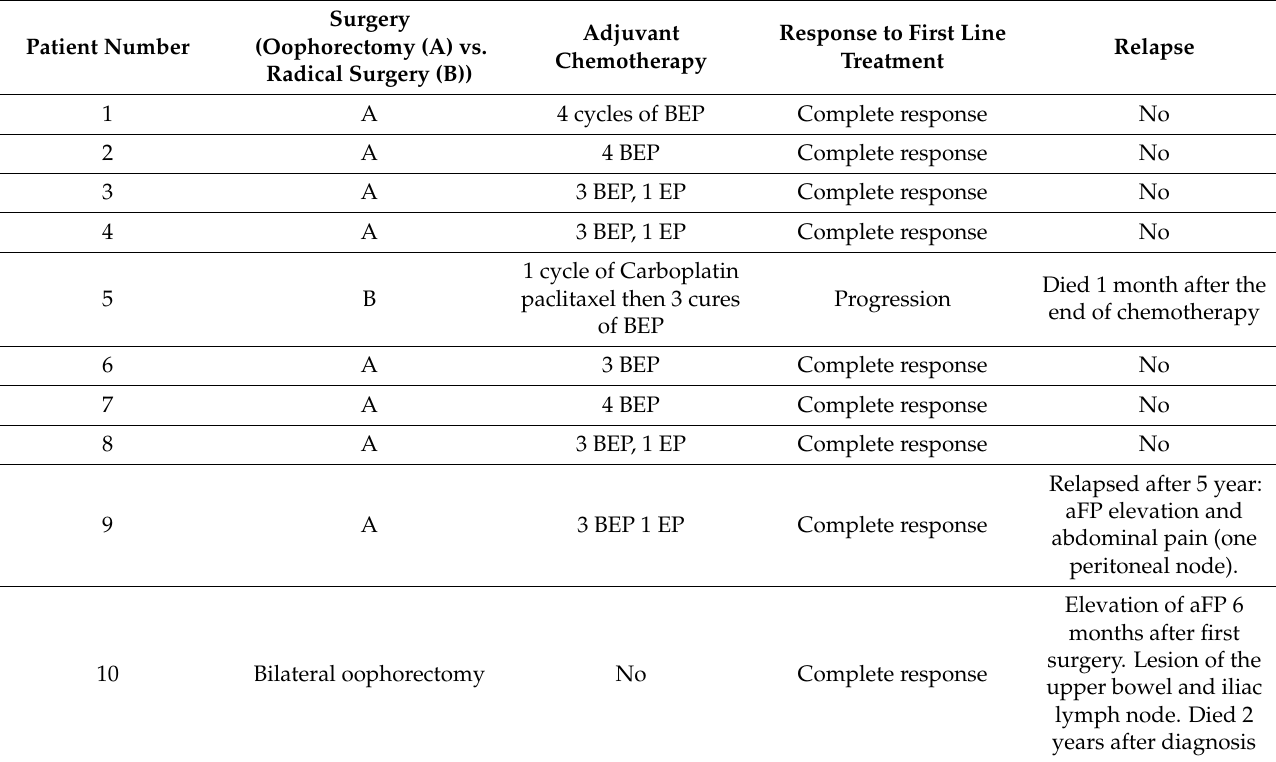
Table 2. Patient initial